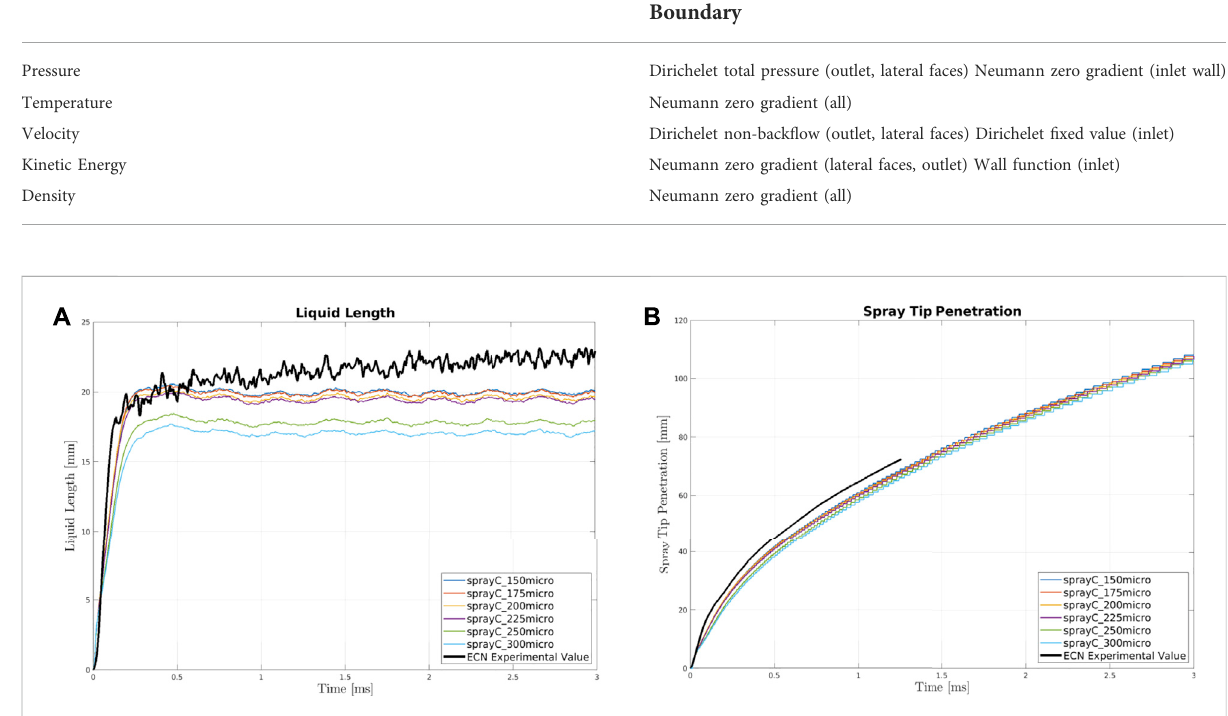
FIGURE 2 Liquid Length (A) and Spray Tip Penetration (B) for Spray C at various mesh